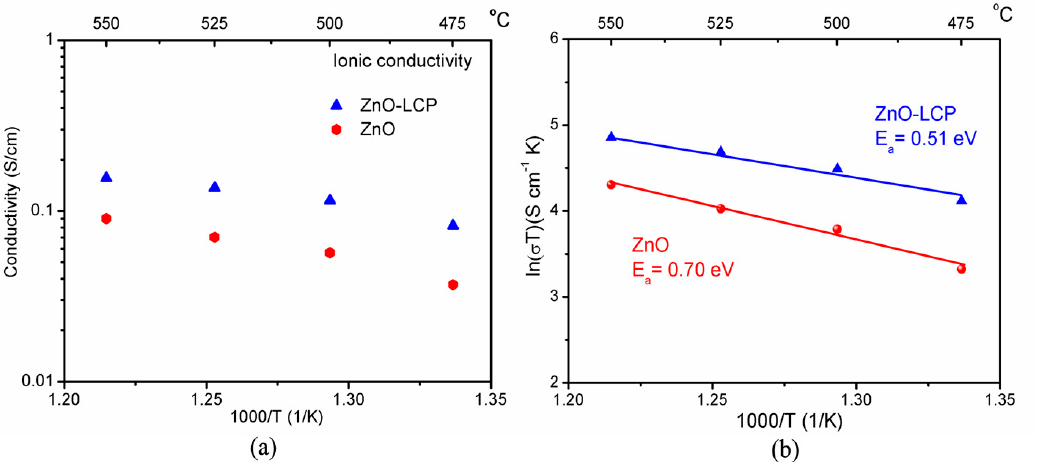
Figure 5. ( a ) Ionic conductivities of ZnO electrolyte and ZnO-LCP composite estimated from I-V curve result; ( b ) The corresponding activation energy of the ionic conductivities for ZnO and ZnO-LCP composite.